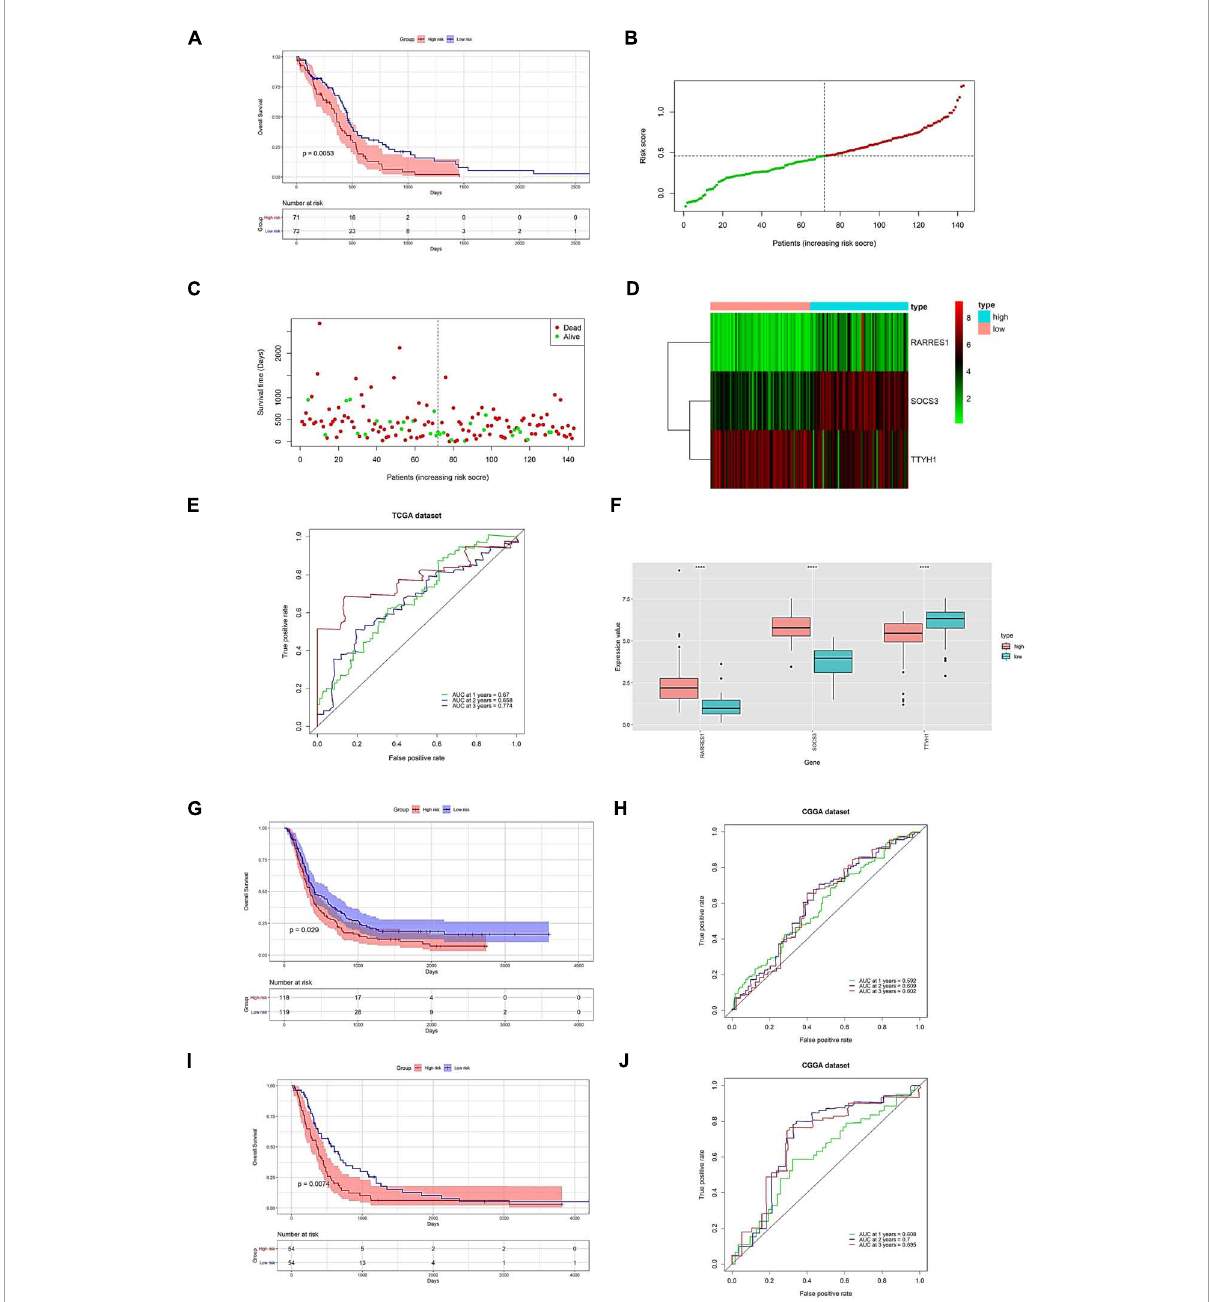
FIGURE7 Prognostic model prediction efficacy assessment and validation on external datasets. Evaluation of predictive power (A–F) . (A) Survival analysis of high and low expression groups. (B) Risk score distribution. (C) Distribution of patient survival. (D) The expression of the hub gene. (E) Predicted ROC curve for 1–3 years. (F) Model genes are shown differentially in high-risk and low-risk. Validation of prognostic models on external datasets (G–J) . (G,I) Survival analysis of high and low expression groups. (H,J) Predicted 1-, 2-, and 3-year ROC curves. (G,H) Data for 693 samples in CGGA. (I,J) Data for 325 samples in CGGA. **** p <